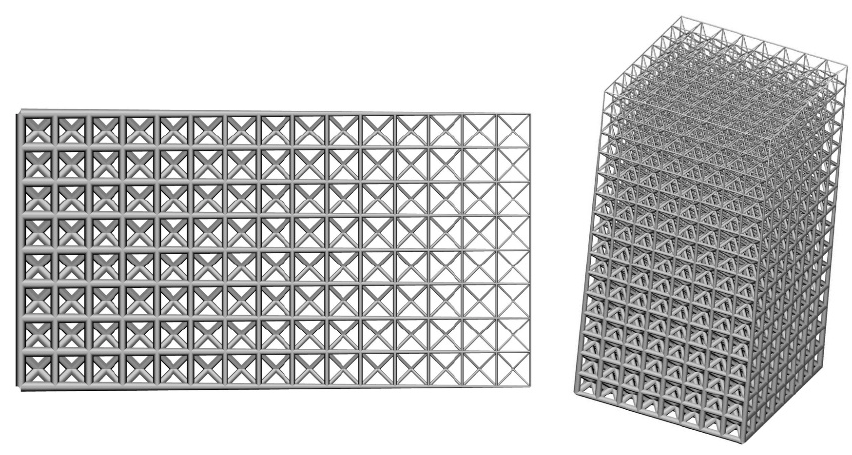
Figure 5. Cuboid lattice structure with linear gradient cross-sectional areas of the bars.